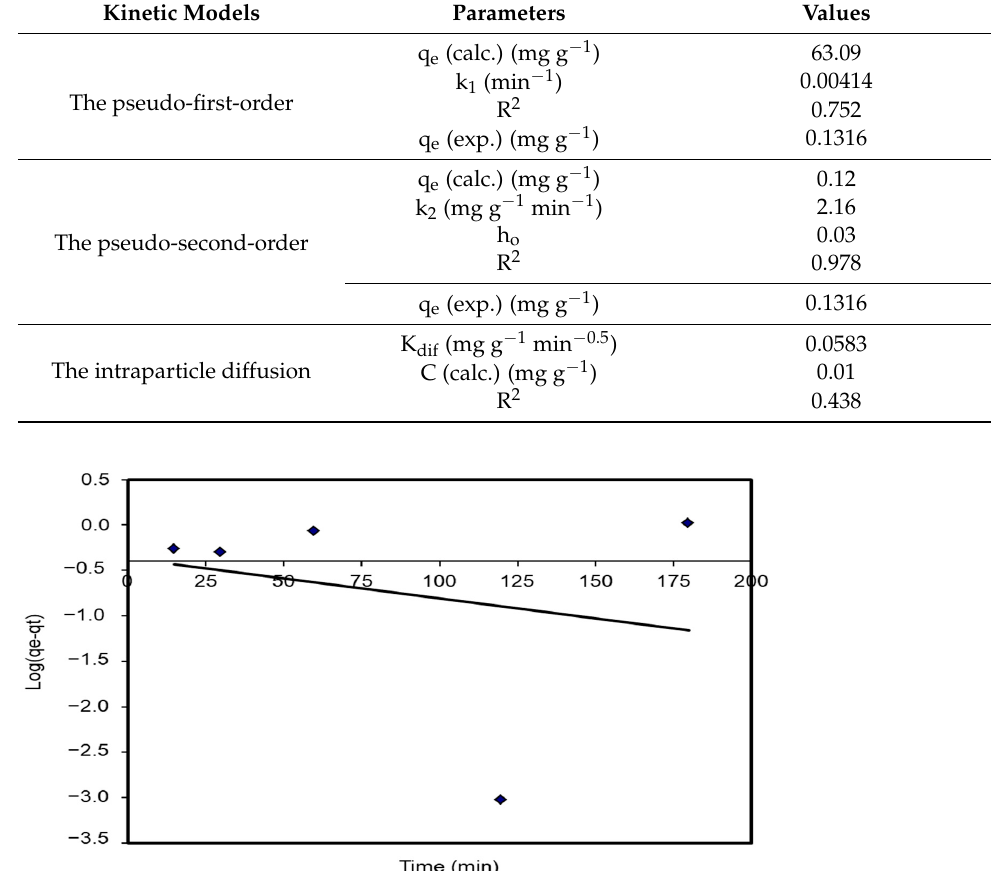
Figure 15. Pseudo-first-order plots for the adsorption of CVD onto S. costatum .